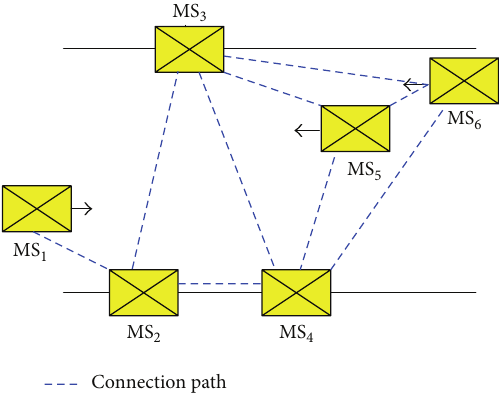
Figure 7: Initial state of networks used in simulation in the case of multihop ad hoc